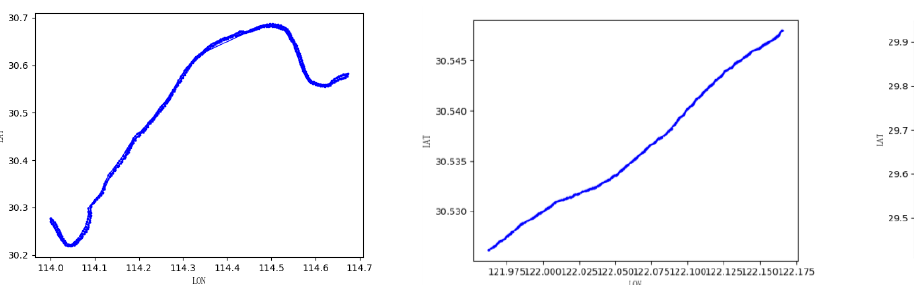
Figure 9. The original trajectories of experimental ships.